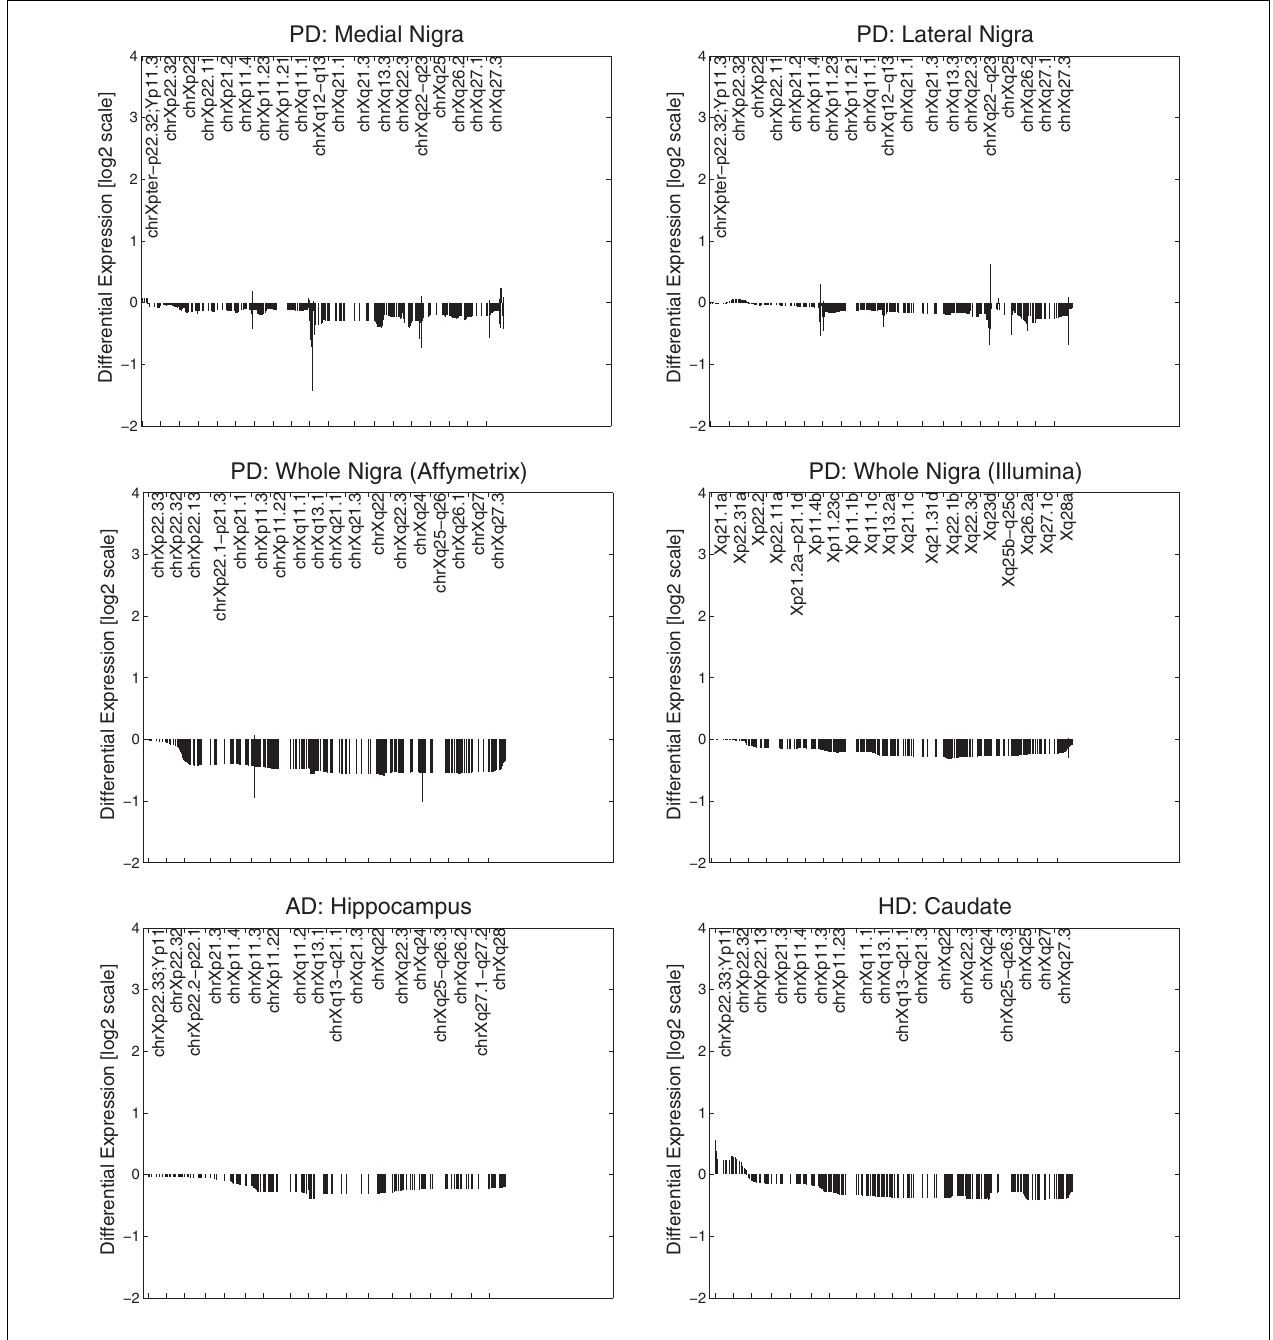
X-expression associated with reduced neuronal reporter gene expression, positive values indicated increased expression. Reduced expression is also associated with neurological disease.The patterns demonstrate reduced gene expression over the majority of ChrX with the exception of the p